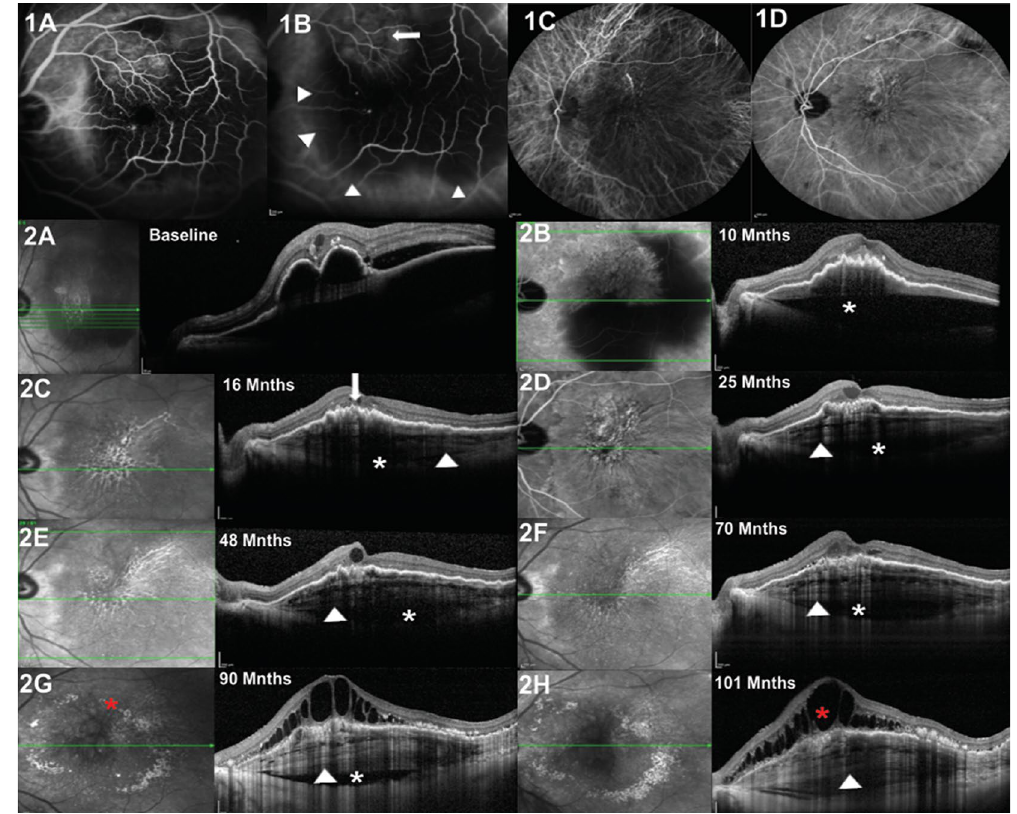
Figure 3. Left eye of an 83-year-old male with age-related macular degeneration (nAMD) and multilayered pigment epithelial detachment secondary to chronic anti-vascular endothelial growth factor (anti-VEGF) therapy (s-MLPED). Baseline angiography shows a neovascular network (arrow) with large pigment epithelial detachment (PED; arrowheads) ( B ). An increase in the size of the network was noted on follow-up indocyanine green angiography (ICGA; D ). Serial cross-sectional optical coherence tomography (OCT) over a period of 101 months shows an increase in multilayering (arrowhead) with a persistent choroidal cleft (white*) and irregular crenated retinal pigment epithelium (RPE; arrow; A – H ). The onset of Multilayering was seen at 16 months after starting anti-VEGF therapy ( C ) which continued to increase during treatment ( D – H ). Persistent intraretinal fluid and exudation (red*) can be seen late during follow up ( G , H